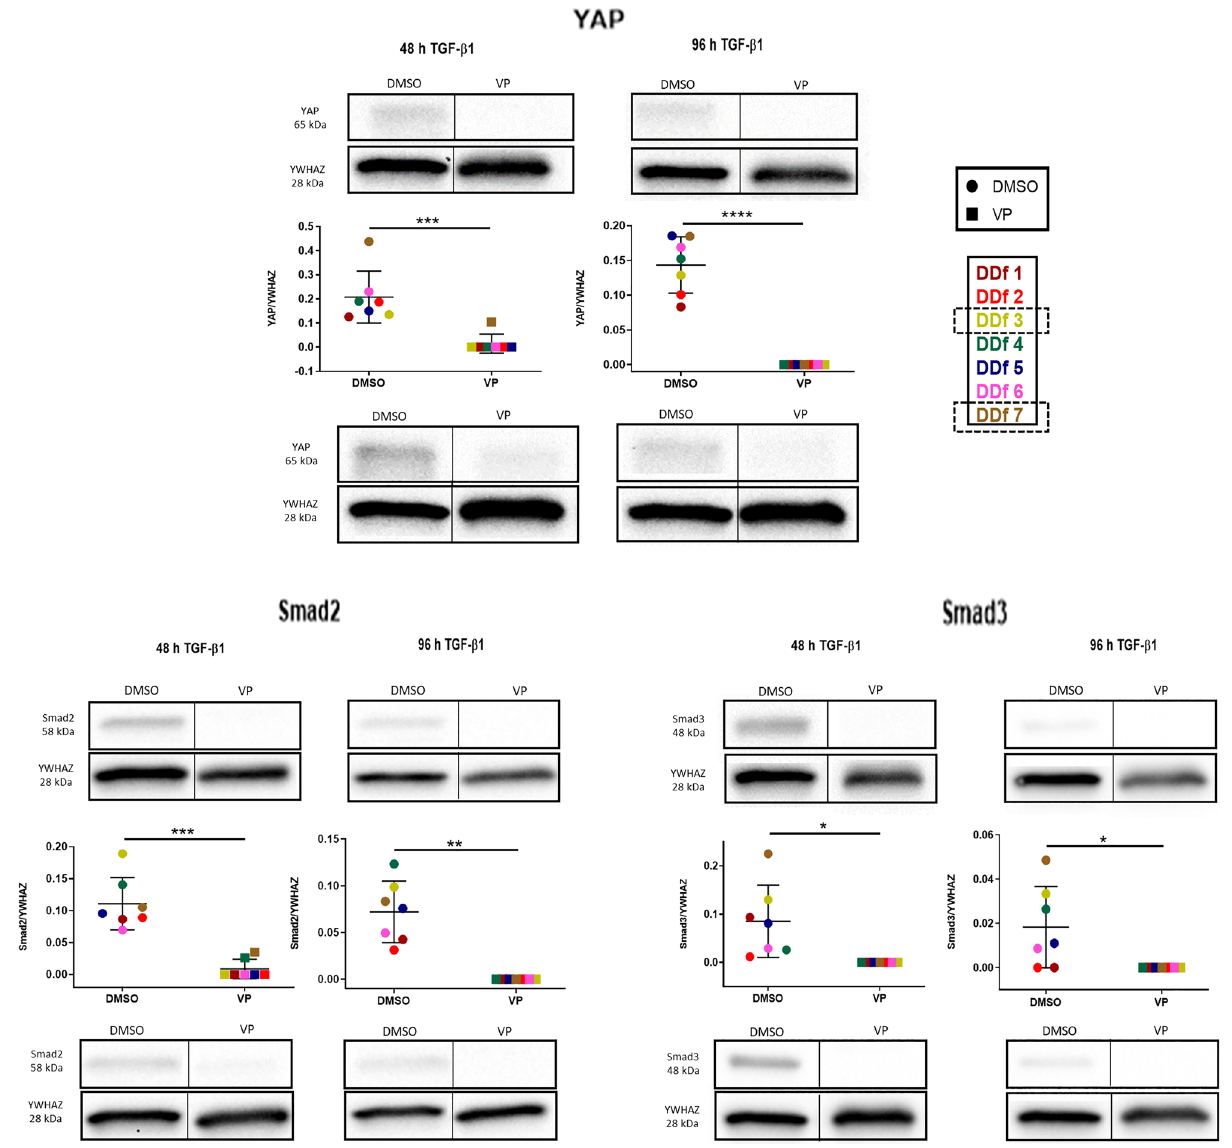
Figure 9. Effect of VP treatment on TGF-β/Hippo pathway downstream effectors. Western blot analysis and quantification of YAP, Smad2, and Smad3, after stimulation with TGF-β1 for 48 h followed by 48 h in the presence or absence with VP, or after stimulation with TGF-β1 for 96 h but in the last 48 h in the presence or absence of VP. Images are shown from donors with a high and low expression (high: patient DDf3 and low: patient DDf7). Original blots are presented in Supplementary Figs. 3 and 4 (S3 and